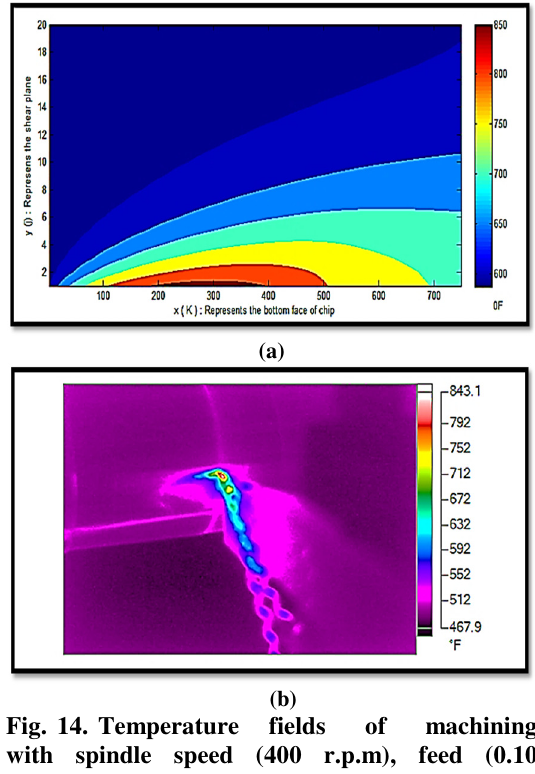
Fig. 12. Effect of spindle speed on tool life.